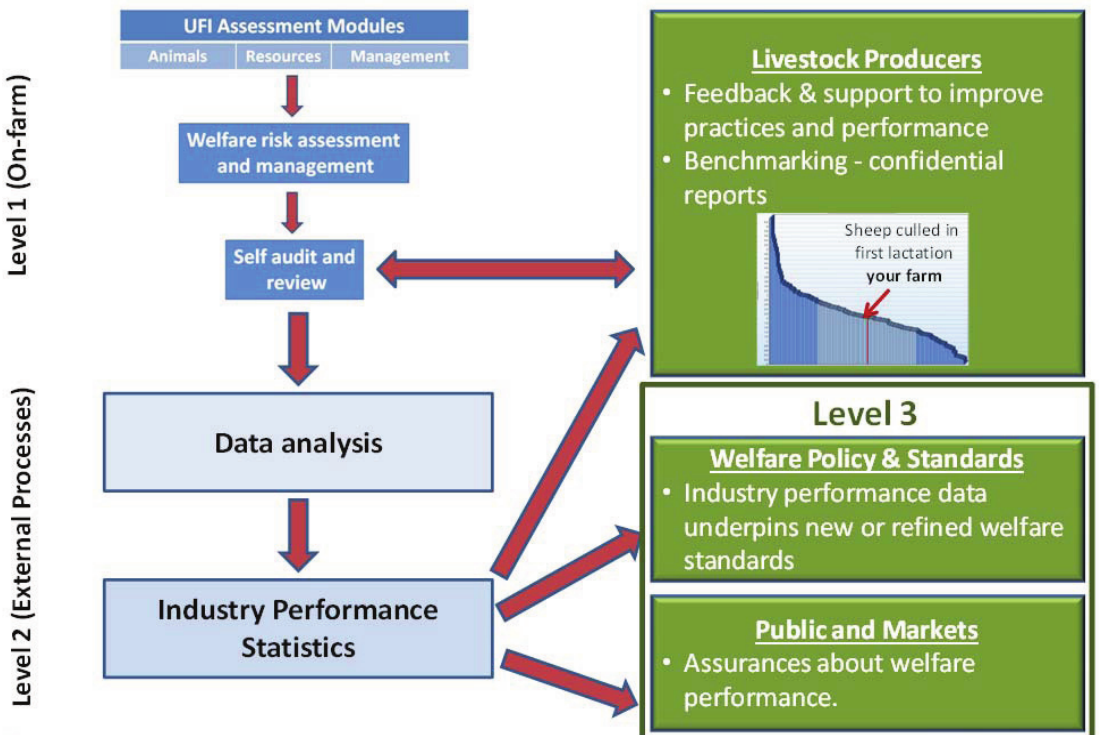
Figure 2. Schematic representation of implementation of the